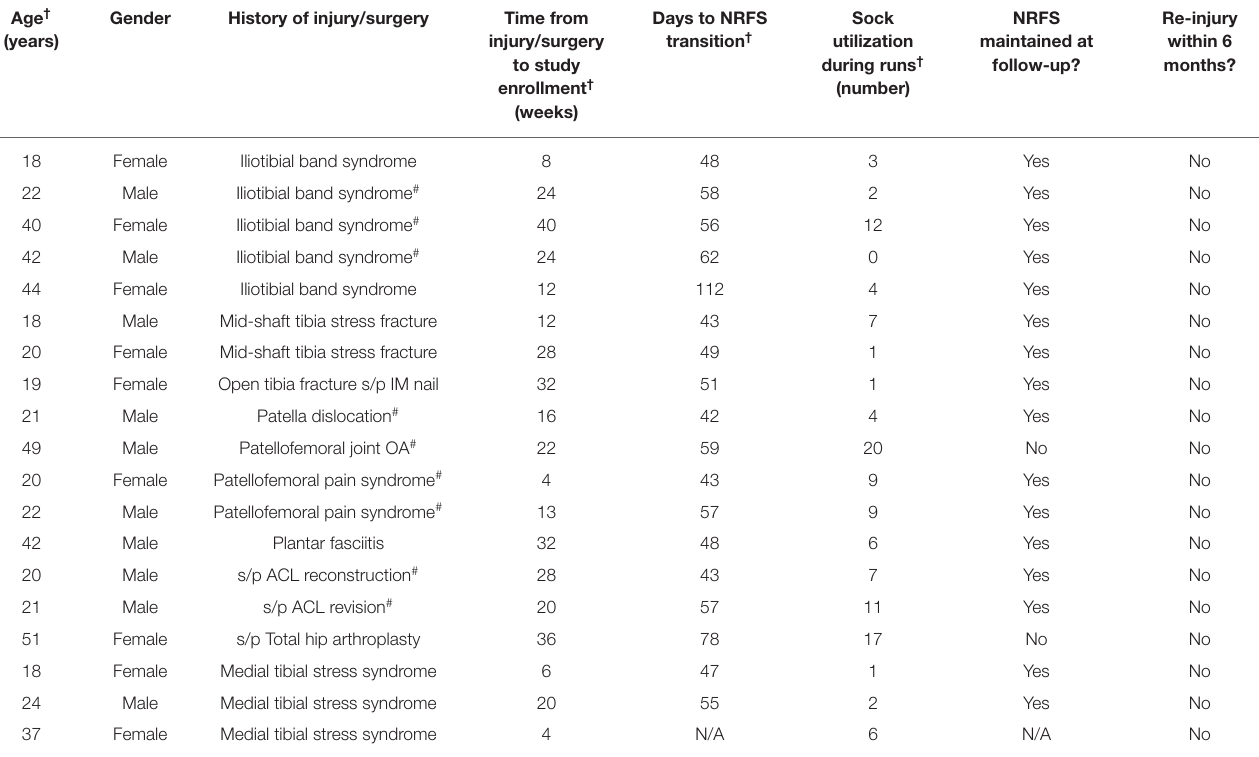
TABLE 1 | Participant demographic, injury/surgery, transition, and re-injury descriptions ( n = 19). Age